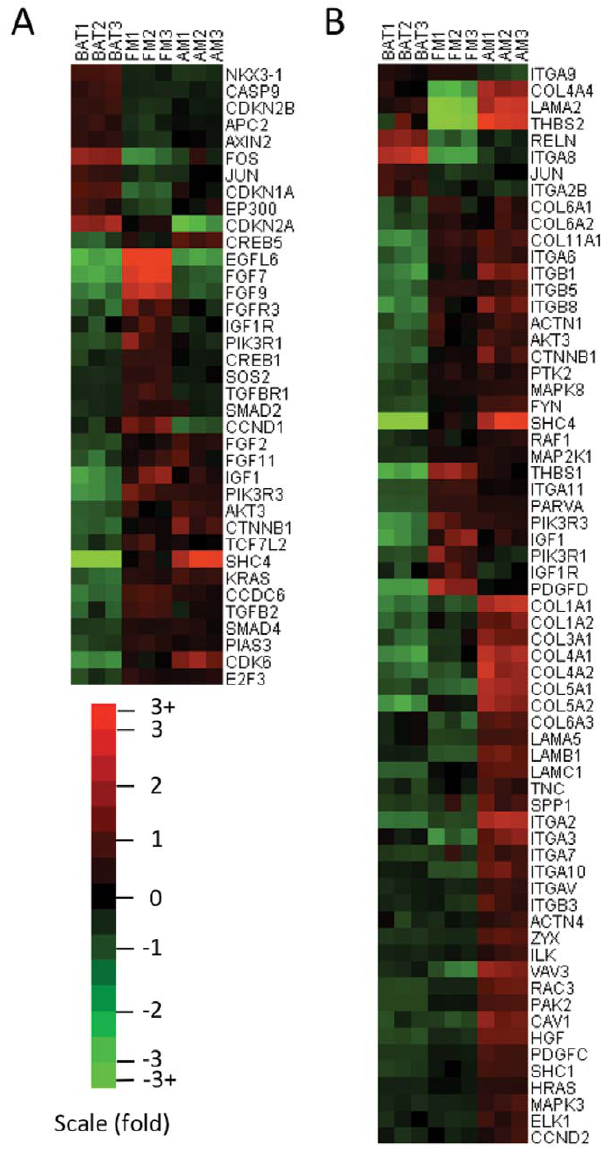
associated with KEGG pathways of fibroblastic meningioma. (B) Expression of genes involved in KEGG pathways of anaplastic meningioma. Key words: BAT, brain arachnoidal tissue; FM, fibroblastic meningioma; AM, anaplastic